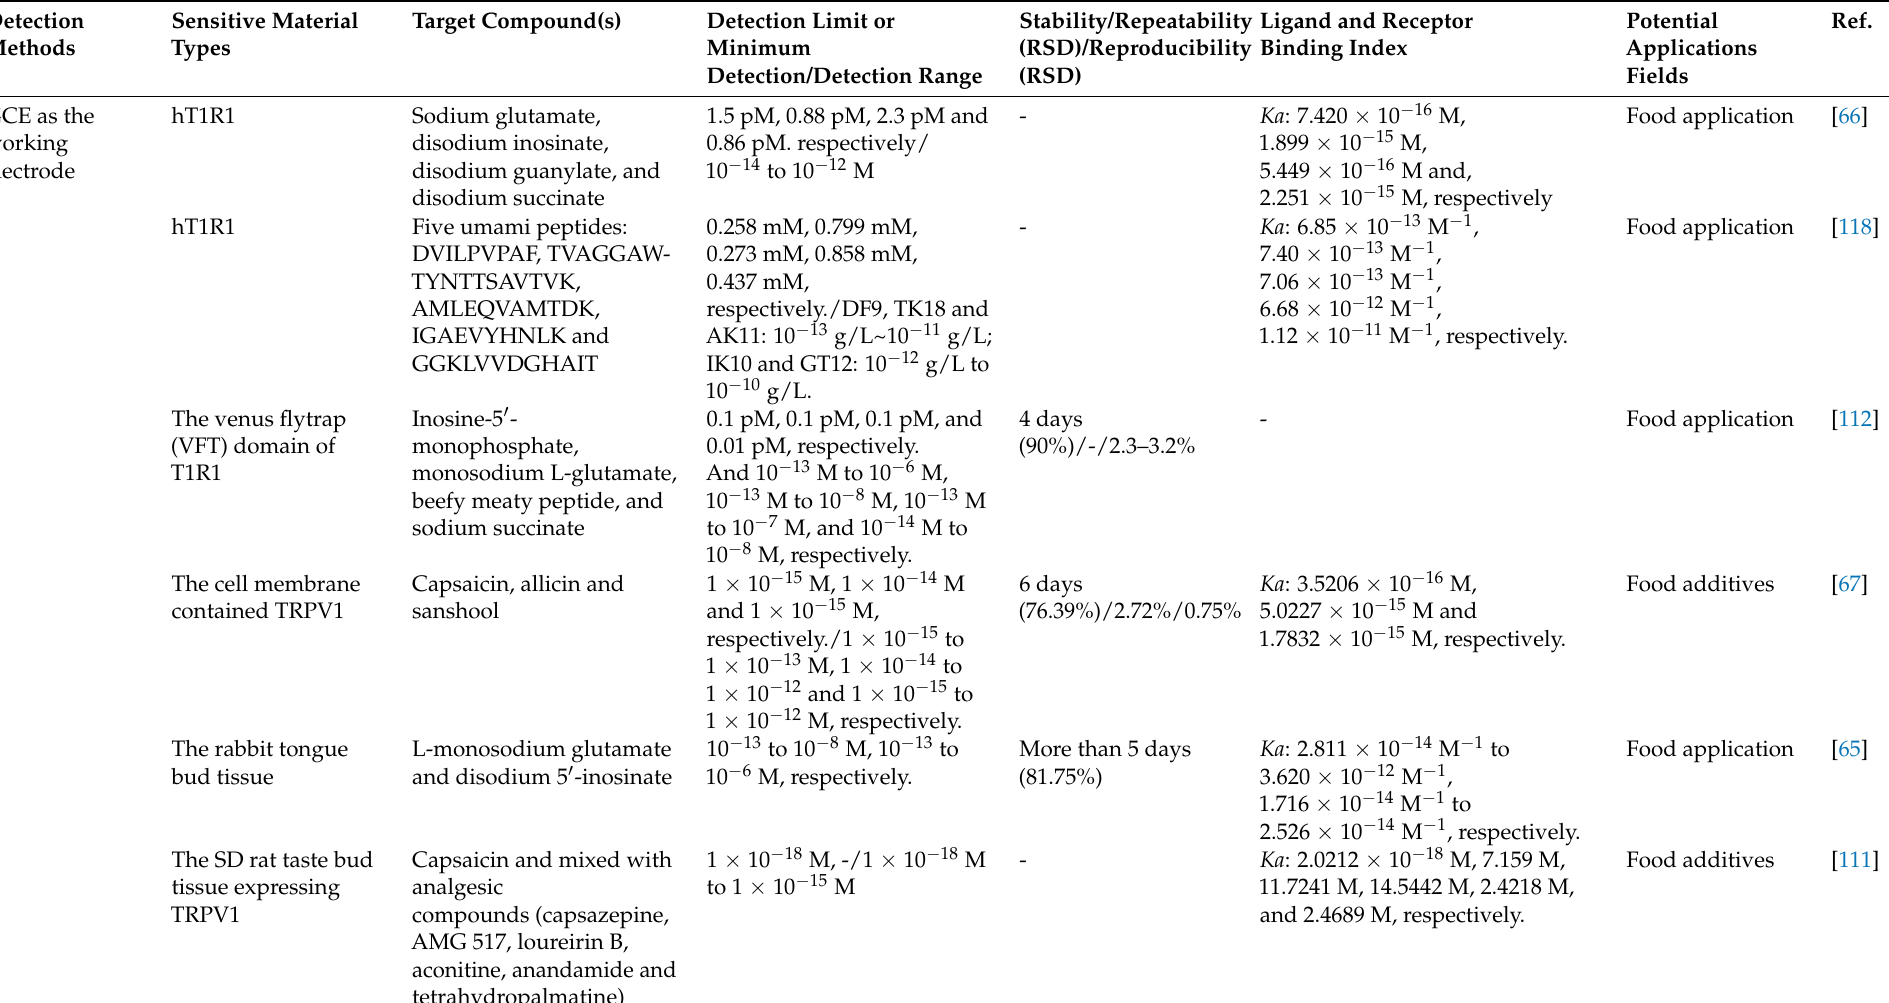
Table 3. Summary of detection strategies on biomimetic olfactory and gustatory biosensors based on electrochemical detection